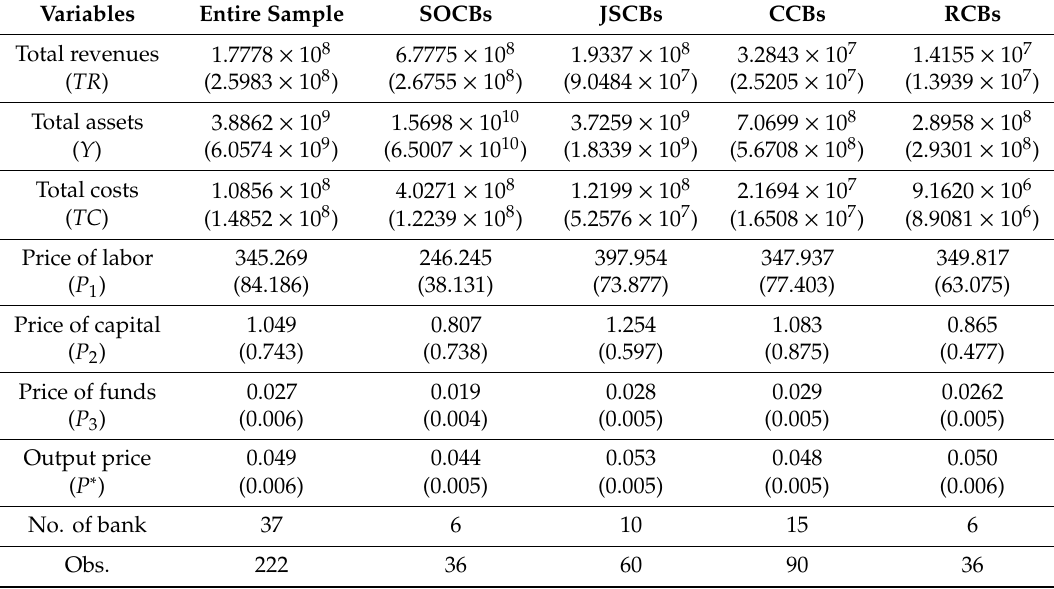
Table 3. Descriptive statistics of used